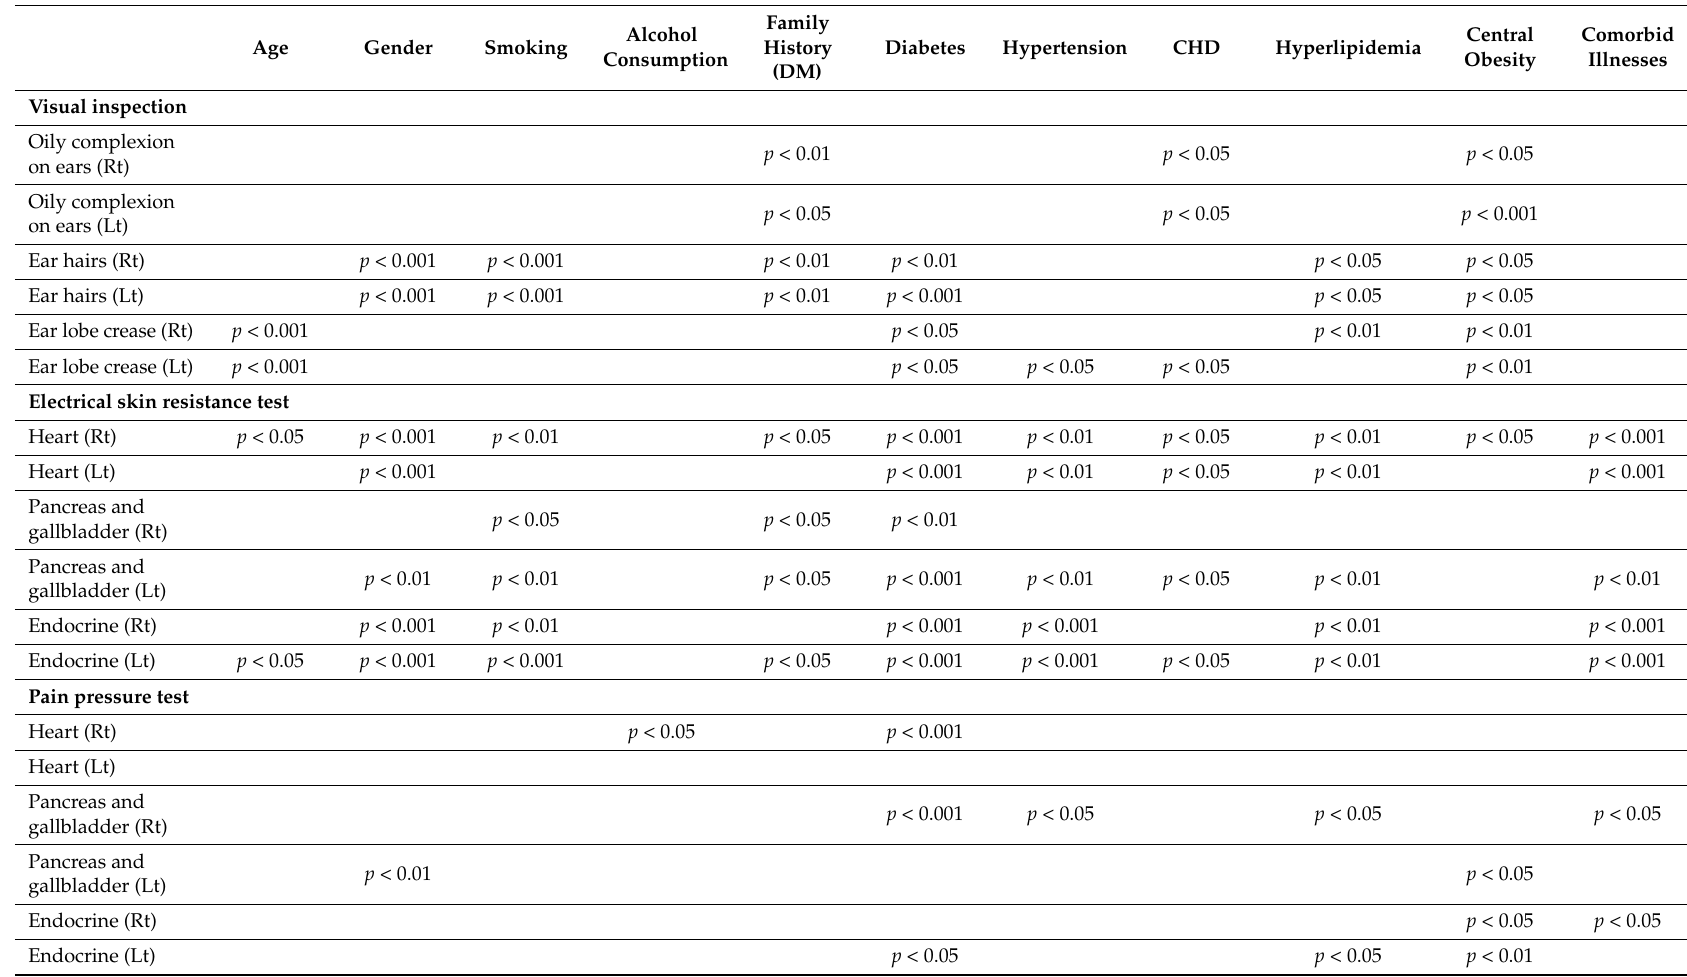
Table 3. Association of auricular signals and risk factors of metabolic syndrome # ( n =